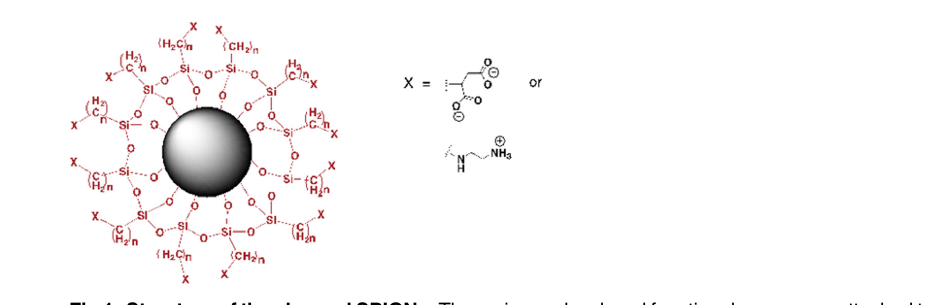
Fig 1. Structure of the charged SPIONs. The amine and carboxyl functional groups are attached to the silica shell on the surface of the